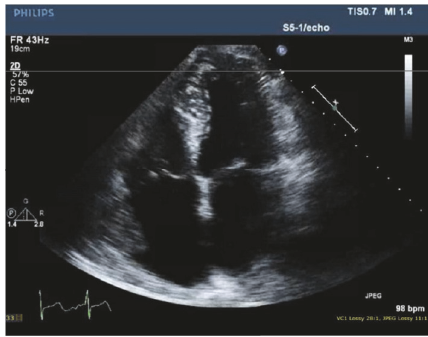
Figure 2: Apical 4 chamber view of 2D echocardiogram showing right atrial mass/clot.